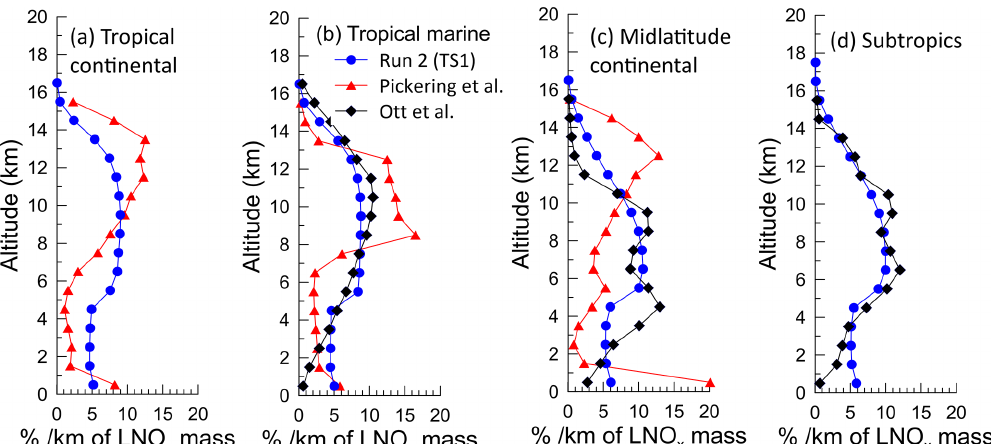
Figure 7. Average vertical distribution of percentage of LNO x mass per kilometre for (a) tropical continental, (b) tropical marine, (c) mid- latitude continental, and (d) subtropical regimes. The total LNO x for these regimes calculated using model Run 1 (PR92) is 3.69, 0.035, 1.09, and 0.74TgNyr − 1 , respectively, whereas that calculated using Run 2 (TS1) is 4.10, 1.09, 1.16, and 0.92TgNyr − 1 , respectively. The vertical profiles from Pickering et al. (1998) and Ott et al. (2010) are also shown (where available).